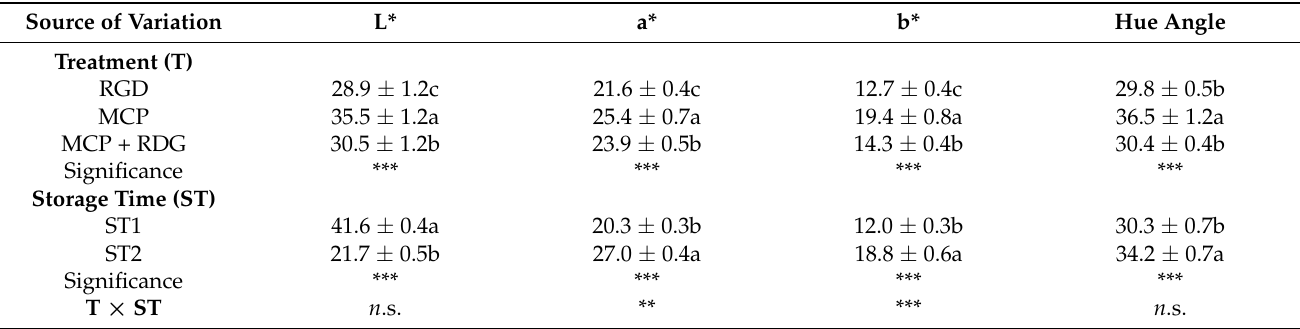
Table 1. Effect postharvest management treatment (T), storage time (ST) and S × T interaction on the skin color of the apples. Source of